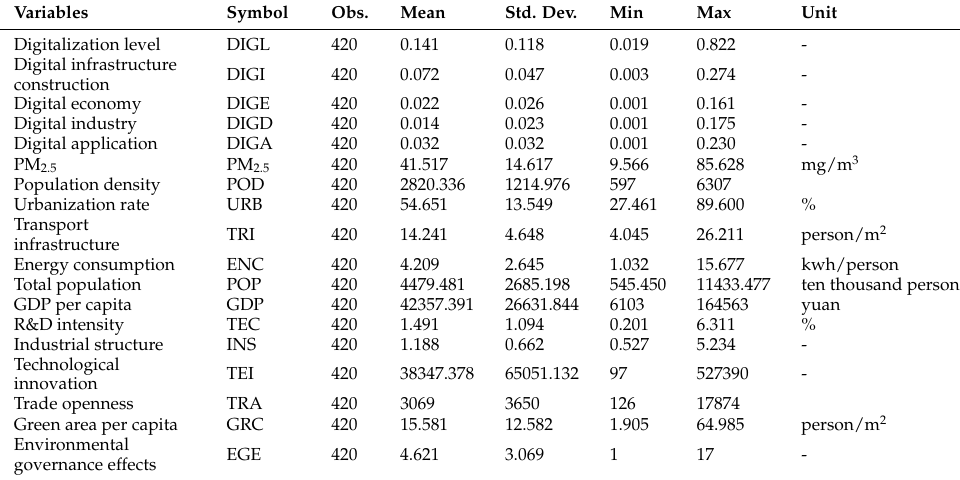
Table 2. The descriptive statistics of variables mentioned in this